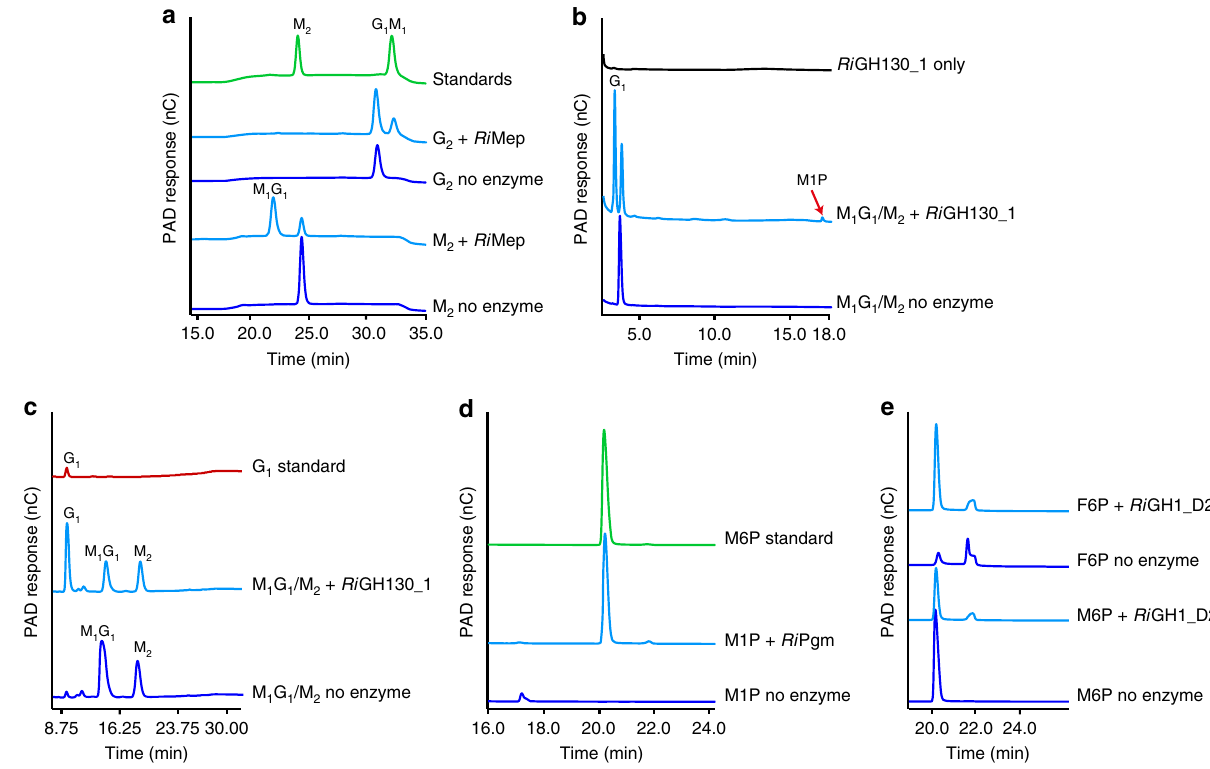
Fig. 5 Enzymes for catabolism of mannobiose, mannosylglucose and monosaccharides deriving from complex β -mannan degradation. a HPAEC-PAD traces showing the epimerization of M 2 and G 2 by Ri Mep to release M 1 G 1 and G 1 M 1 , respectively. b , c HPAEC-PAD of phosphorolysis reactions of Ri GH130_1 using premixed M 1 G 1 plus M 2 from Megazyme. The reaction products were then analyzed using an HPAEC method designed for the separation of b phosphorylated manno-oligosaccharides or c mono-saccharides and di-saccharides. M1P, indicated with a red arrow, and G 1 peaks in b are marked according to the standards. d HPAEC-PAD analysis of Ri Pgm-catalyzed conversion of M1P to M6P. The M6P released was identi fi ed by co-migration with the M6P standard. e Activity of Ri GH1_D2 on M6P and F6P analyzed by (Supplementary Fig. 16b), the Ri Pgm-mediated catalytic activity was detected only when MgCl 2 was present in the reaction.